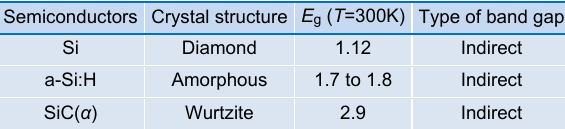
Table 5 | Band gap information for various silicon structures 7